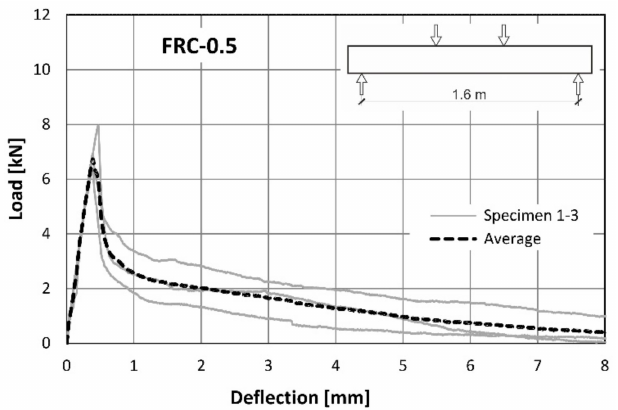
Figure 10. Load–deflection curves from flexural tests on FRC-0.5.